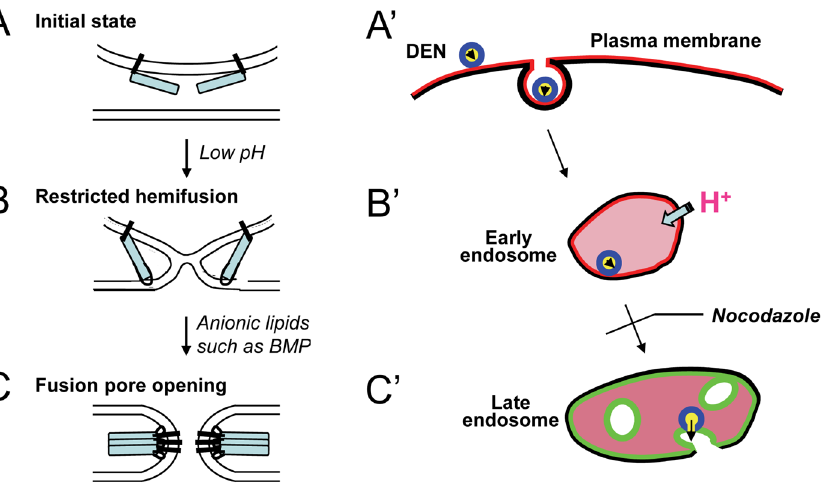
Figure 7. The schematic diagram that illustrates the proposed mechanism of DEN entry. Left panel ( A , B , C ) illustrates enlargement of the fusion intermediates corresponding to distinct stages of viral entry shown in the right panel (A’,B’, C’). A. Initial state of membrane contact. DEN E lays along the surface of the viral envelope. B. Acidification in the presence of AL-free target membrane (for instance, in the early endosome) destabilizes the E dimers and allows E monomers to interact with the target membrane. These interactions result in formation of the earliest hemifusion intermediates that do not support lipid mixing between the membranes. C. Protein E interaction with AL-enriched target membrane (for instance, late endosomal membrane) allows productive insertion of the fusion loop of E required for homotrimerization of E protein. Homotrimers of E drive the transition from restricted hemifusion to complete fusion. The panel on the right ( A’ , B’ , C’ ) summarizes the proposed pathway of the DEN entry. While endocytosed viral particles in early endosomes are already exposed to environment acidic enough to trigger conformational changes in DEN E ( B’ ), most of the virions neither inactivate nor advance in fusion beyond restricted hemifusion until microtubule-dependent trafficking delivers them into the late endosomal environment and, for the first time during entry, virions come into contact with an AL-enriched target membrane ( C’ ). Virion fusion to the AL BMP-enriched membrane of late endosomes (shown in green) delivers viral RNA to its translation-replication sites at pre- and post- lysosomal